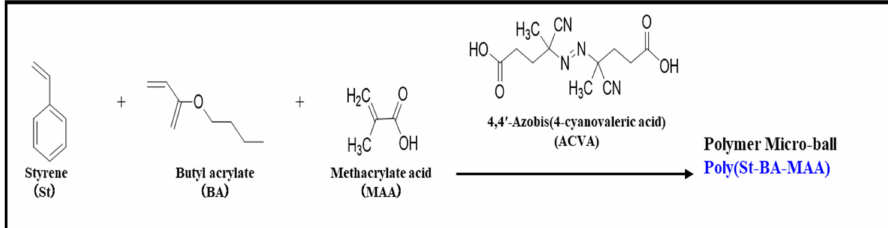
Figure 1. Chemical synthesis to fabricate polymer